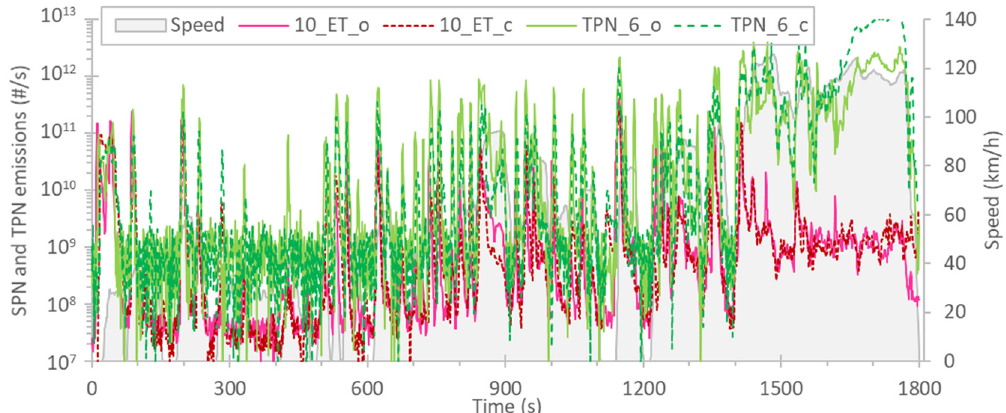
Figure 7. Real time total particle number (TPN) or solid particle number (SPN) emissions with the open (o) and closed (c) configurations. ET = evaporation tube.